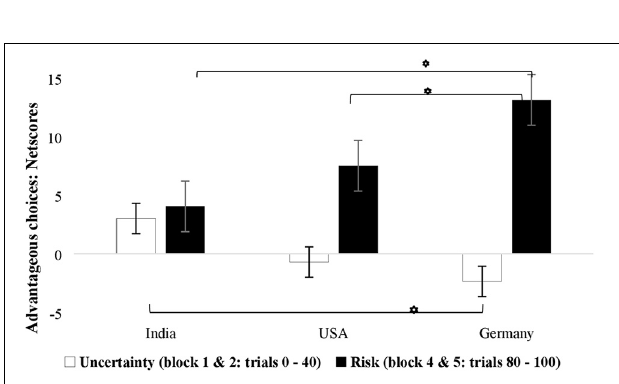
FIGURE 3 | Country-specific advantageous decision making of female participants under uncertainty (trials 0–40) and risk phase of the IGT (trials 80–100). Error bars represent standard error.